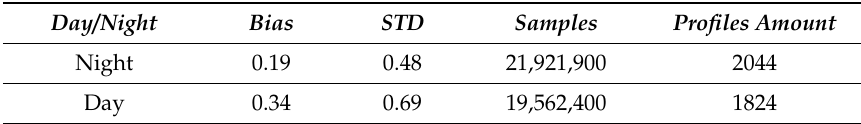
Table 5. Overall evaluation